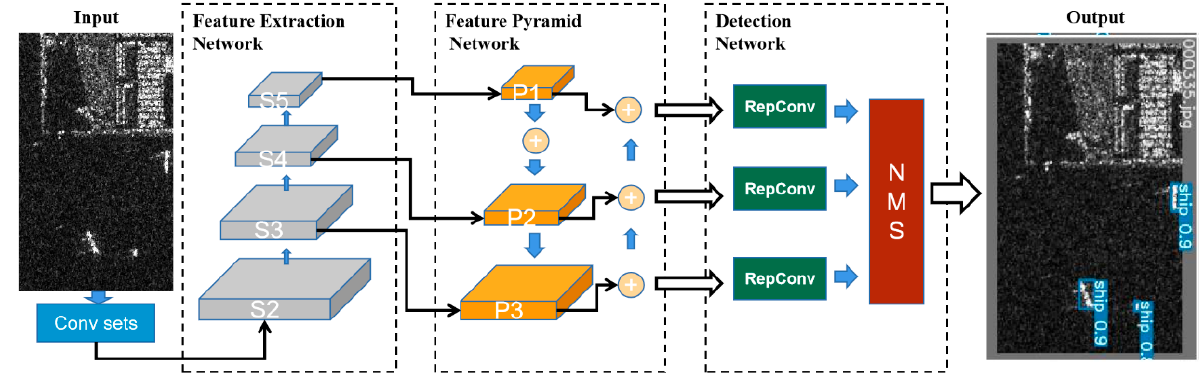
Figure 2. Overall structure of